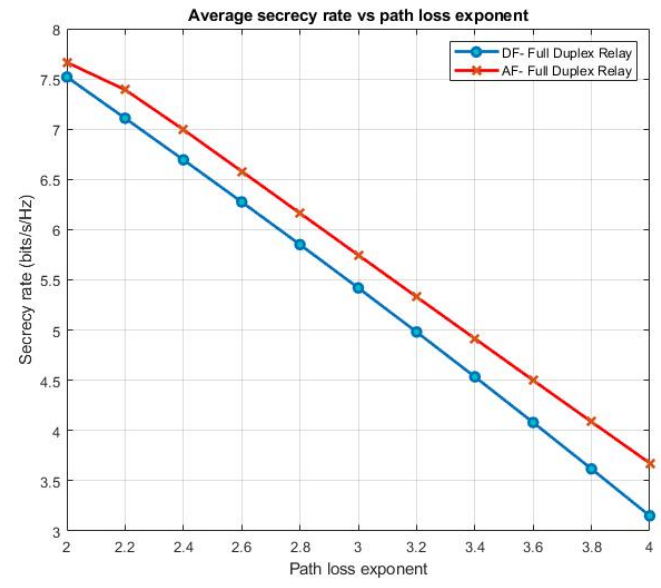
Figure 12. Secrecy Rate vs. Path Loss Exponent.